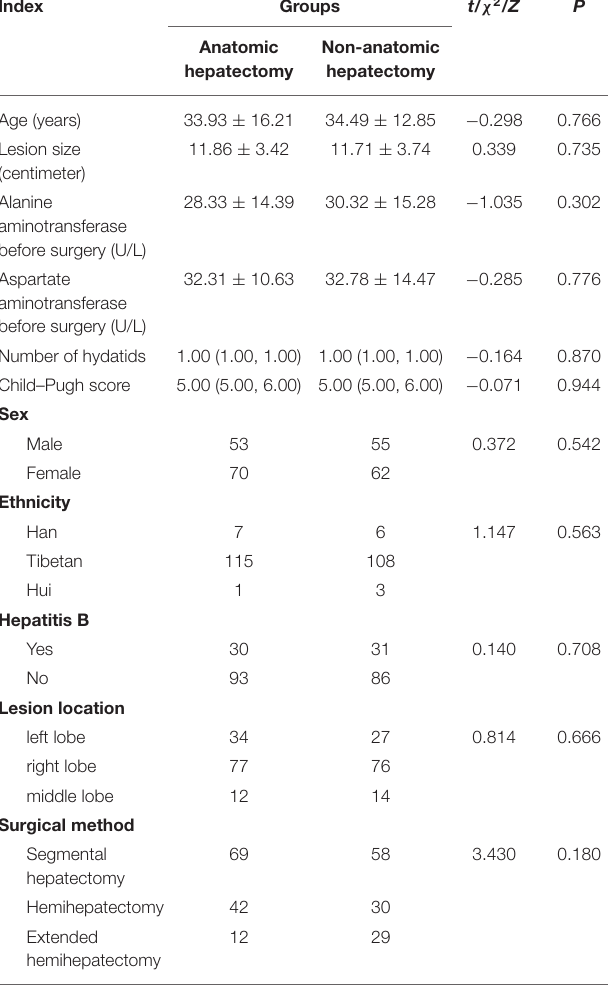
TABLE 1 | Comparison of baseline data between the two groups.